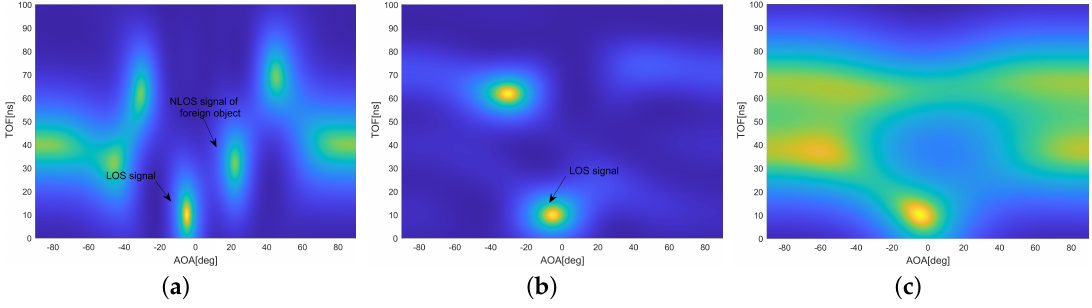
Figure 12. Impact of spatial smoothing and phase calibration on AOA estimation. ( a ) With spatial smoothing and phase calibration. ( b ) Without spatial smoothing. ( c ) Without phase